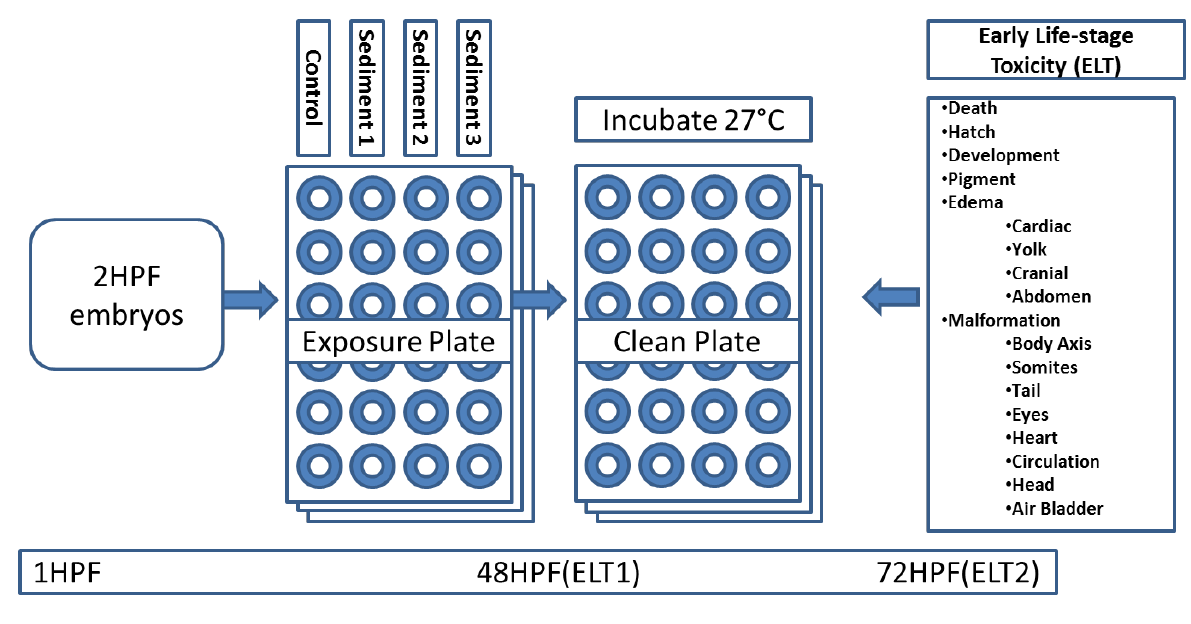
Figure 2. Conceptual Diagram of Experimental